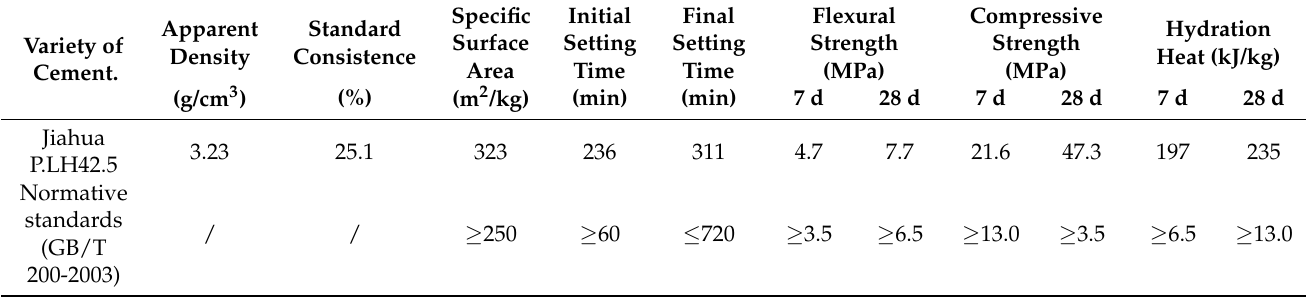
Table 1. Physical properties, mechanical properties, and hydration heat of low-heat Portland cement.